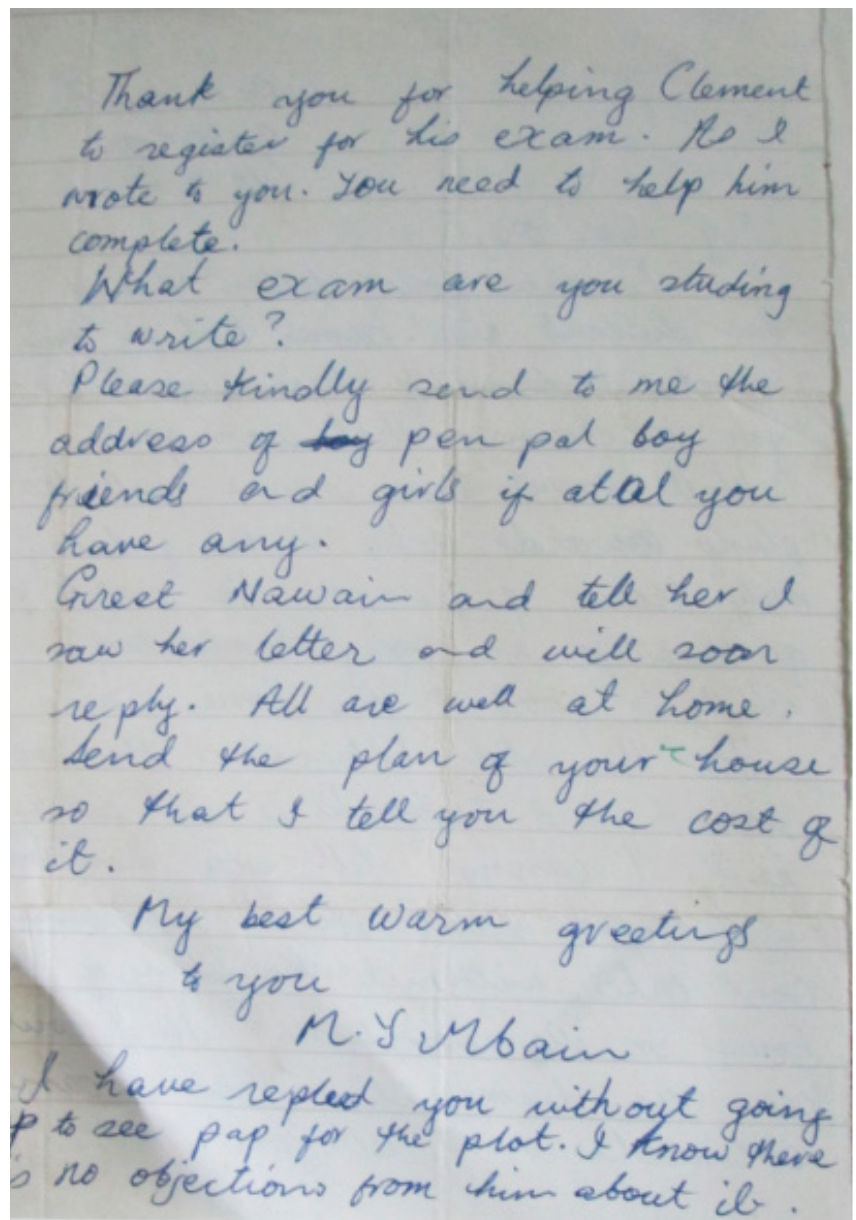
Figure 1. Letter written by M. Y. Mbain. There were also letters that showed tensions in families at home and in distant